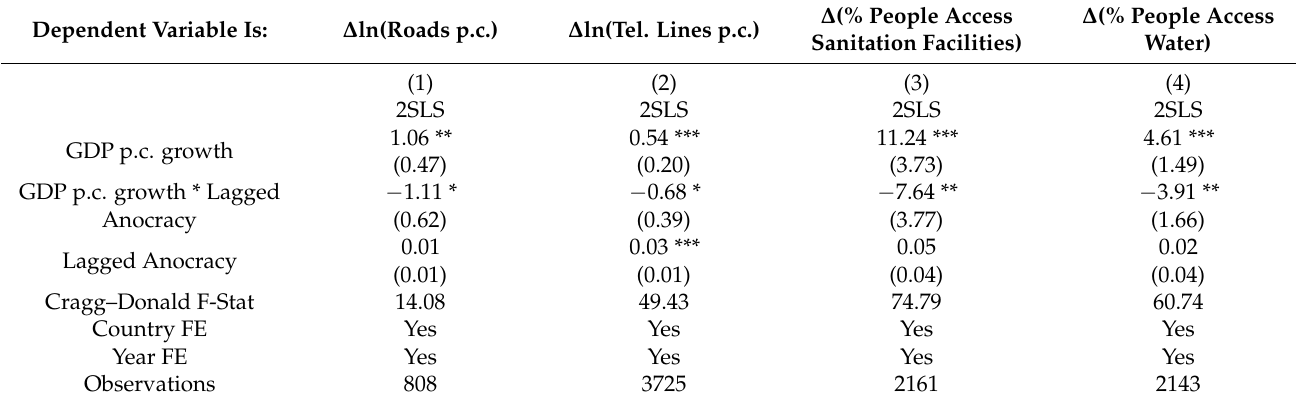
Table 8. GDP growth, anocracy, and infrastructure (interaction